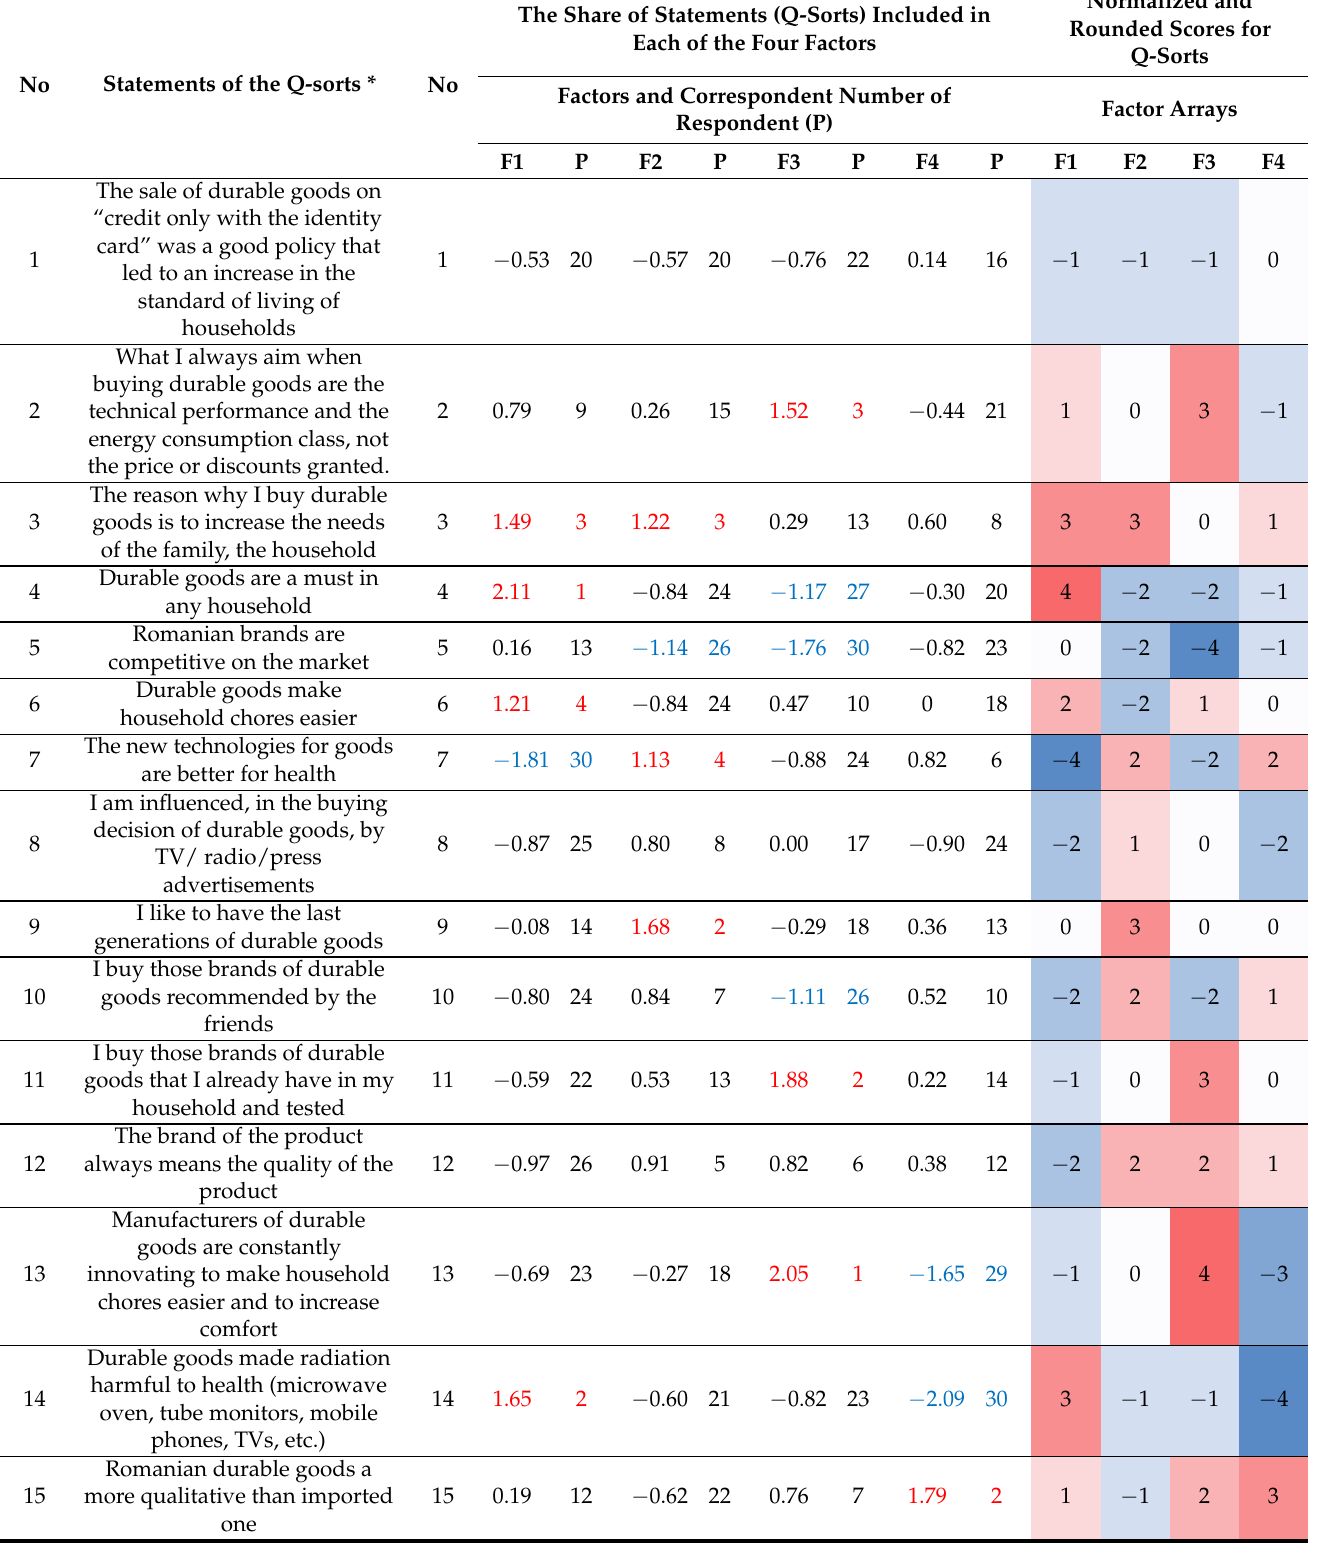
Table 3. The share of statements (Q-sorts) included in each factor, normalized and rounded scores for Q-sorts, and the heat map for final